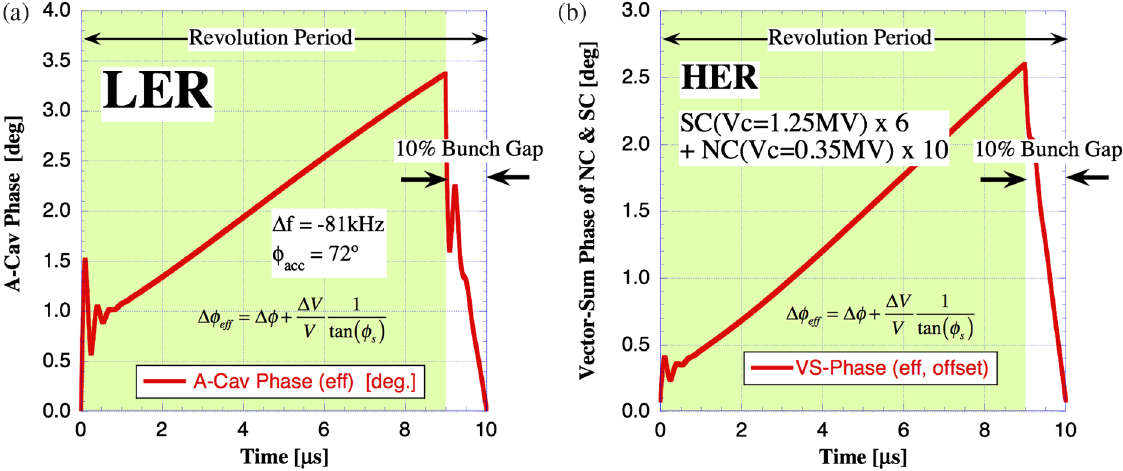
FIG. 4. Simulation results of the phase modulation due to a 10% bunch gap for KEKB operation. (a) LER with the ARES cavities only and (b) the vector sum of ARES and SCC for HER.